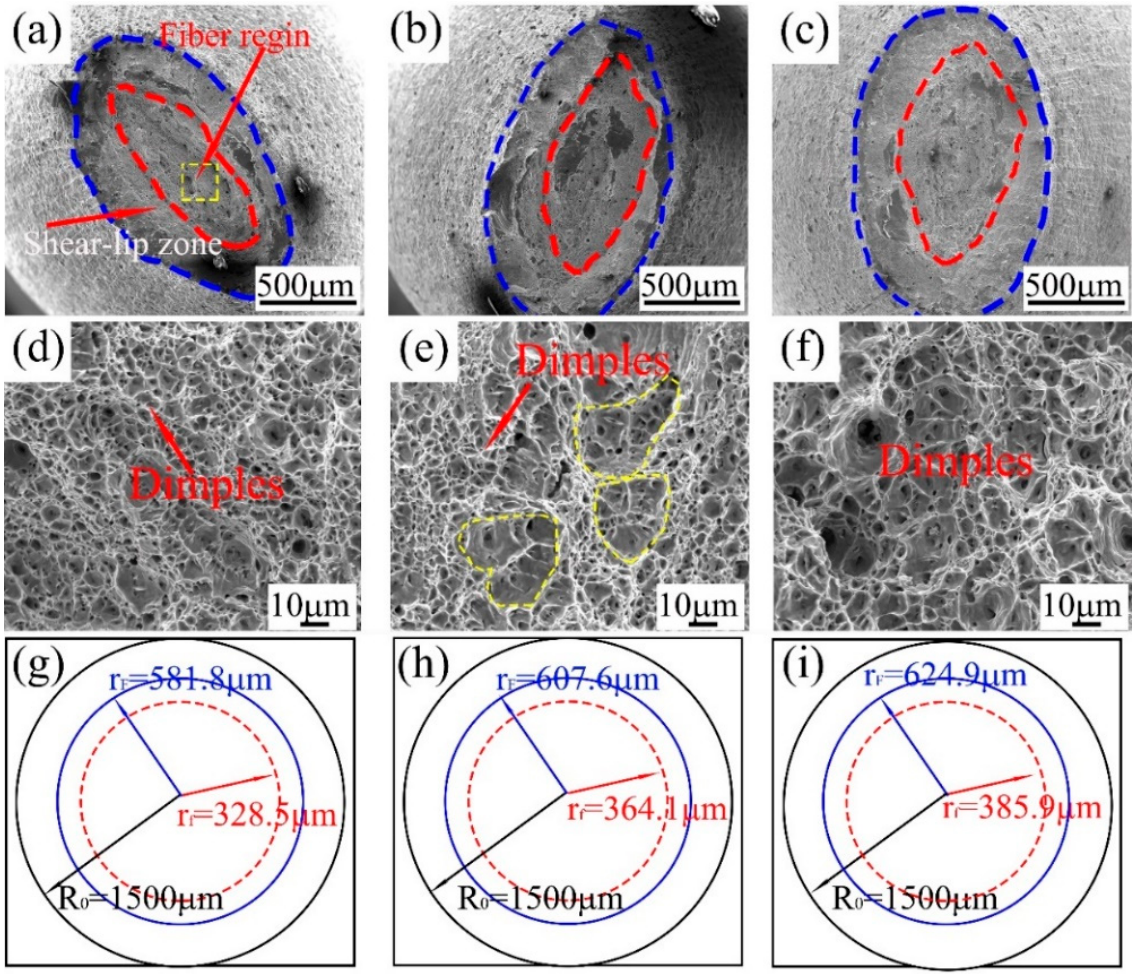
Figure 8. Tensile macro fractography images, microstructures of the fiber zone, and schematic diagram of different fracture zones: ( a , d , g ) single phase, ( b , e , h ) dual-phase, ( c , f , i ) triple-phase.